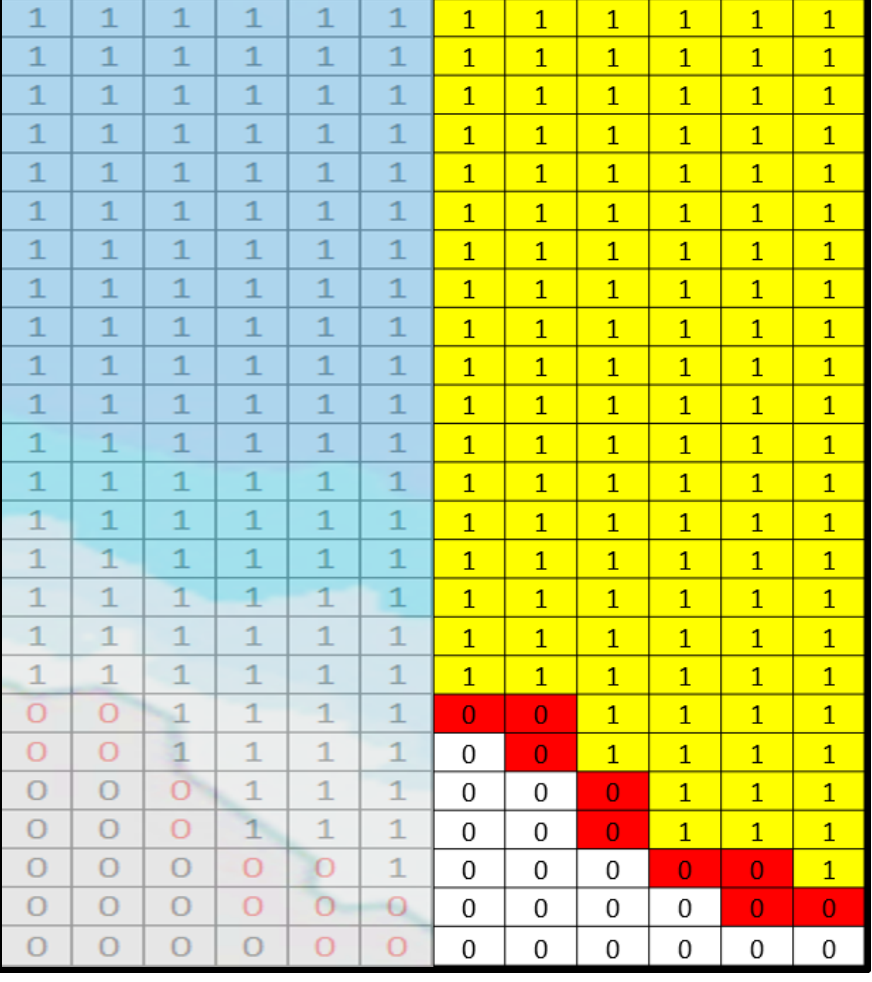
Figure 3. Grid of the offshore wind export cable deployment area. Grid model showing the coastal area ( left ) and numerical model of grid ( right ), 0 means coastal area; 1 means area to be considered.